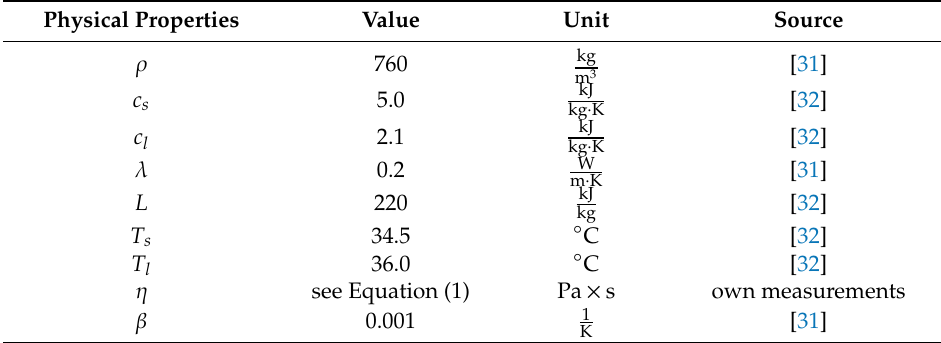
Table 2. Material properties of RT 35—nowadays called RT 35 HC.